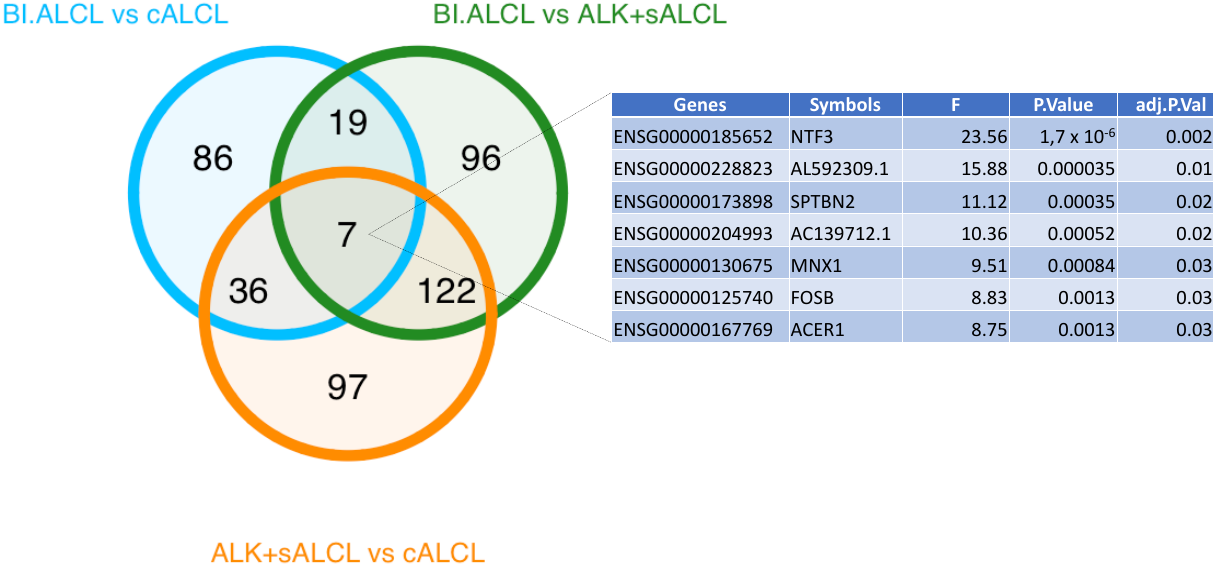
Figure 8. Venn diagram of the differentially expressed genes between BI-ALCLs, cALCLs and ALK+ sALCLs.